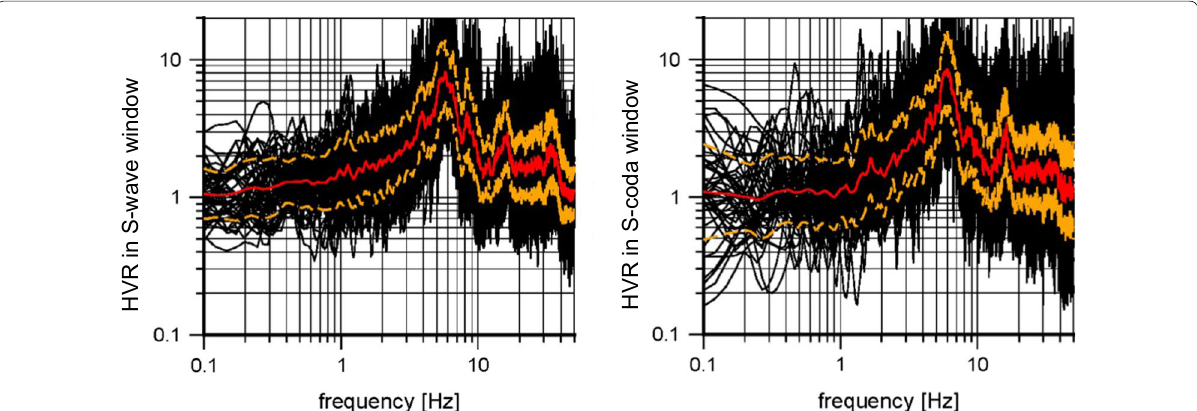
one standard deviation (orange), and individual ±